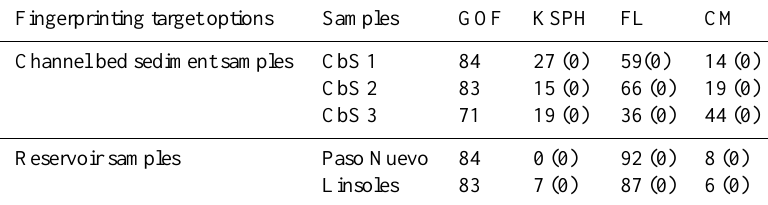
Table 5. Mean percentages of GOF and source contributions (standard deviations) from the multivariate mixing model for Kas- tanozem/Phaeozem (KSPH), Fluvisol (FL), and Cambisol (CM) sources to the Paso Nuevo and Linsoles reservoirs and channel bed sediments (CbS)